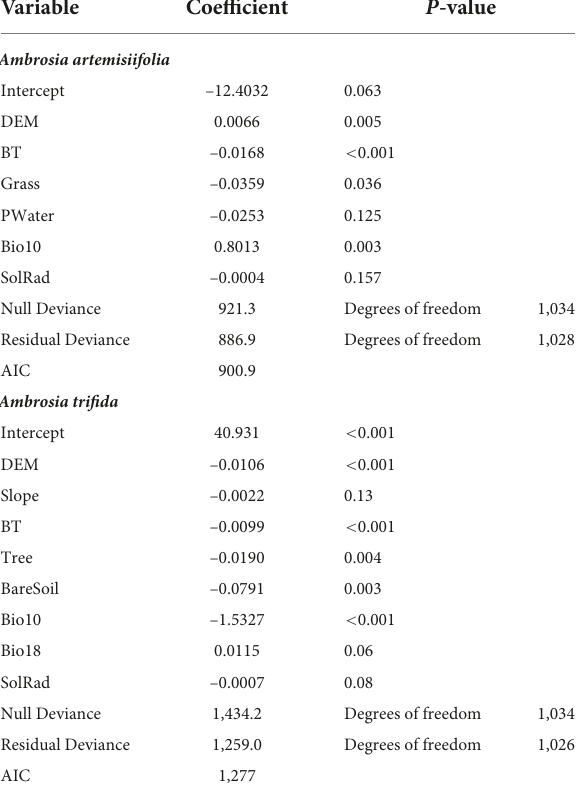
TABLE 1 Generalized linear model (GLM) results with the binomial error structure and logit link function.